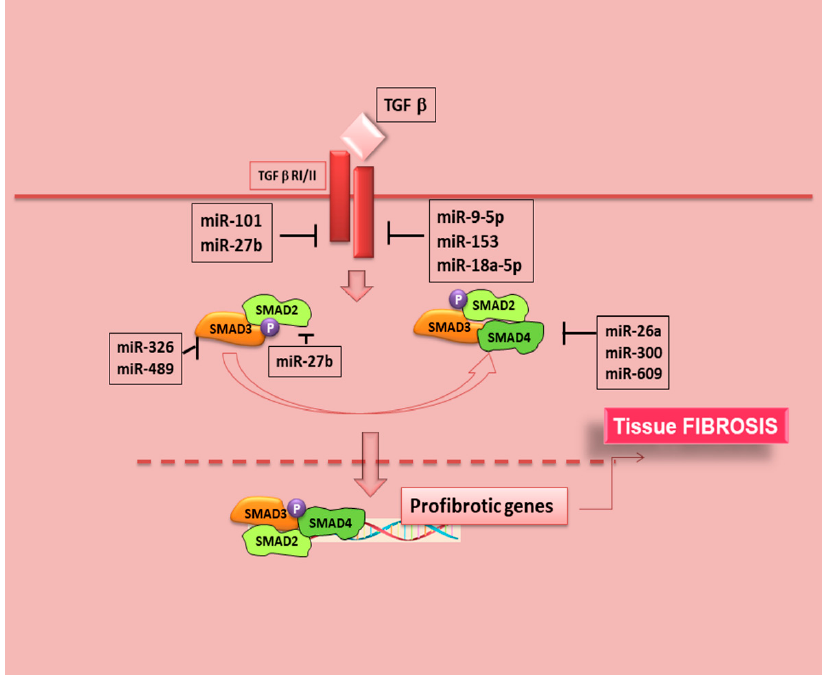
Figure 4. Modulation of the TGF- β signalling pathway by miRNAs. In response to TGF- β signal, the expression of a cohort of miRNAs is modulated. Several miRNAs are involved in the process of EMT-dependent tissue fibrosis by targeting components of the TGF- β signalling pathway. Table 2. MicroRNAs regulate TGF- β /SMAD signalling during fibrosis.